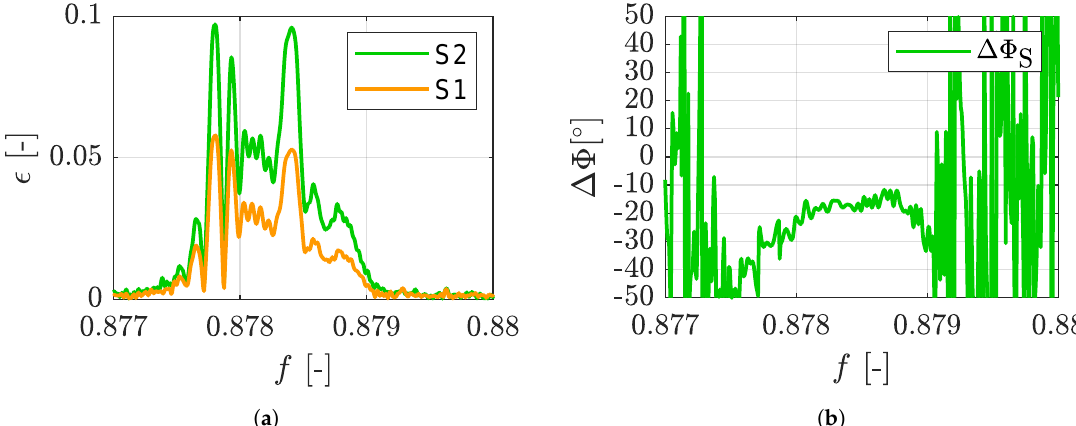
Figure 9. Vibratory Mode 8-2: Shaft vibrations, frequency domain and phase lag. ( a ) Normalized amplitude of both shaft SGs during resonance M8-2; ( b ) Phase lag ∆ Φ S of shaft SGs during resonance M8-2.